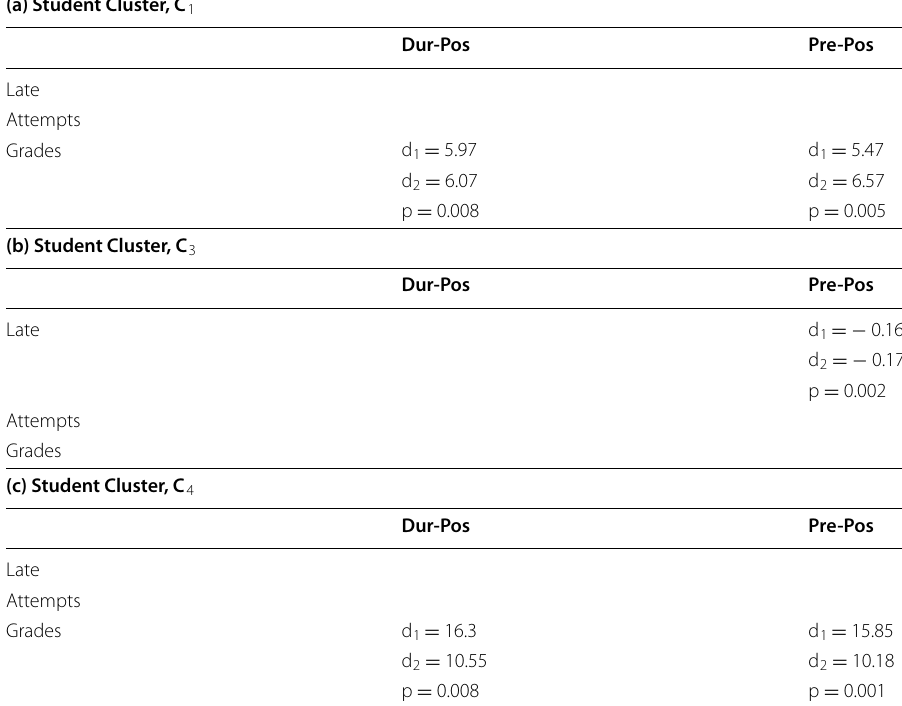
Table 9 Comparisons by using each student cluster (a) Student Cluster, C